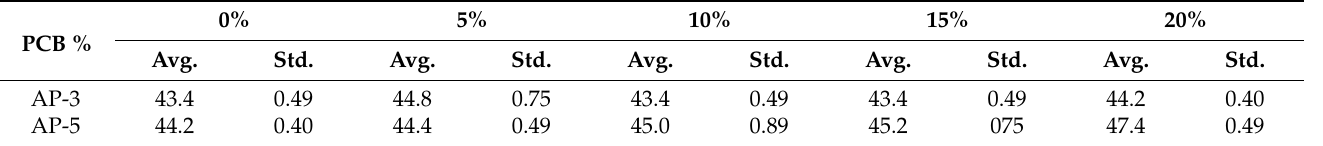
Table 4. Softening point (unit: °C).